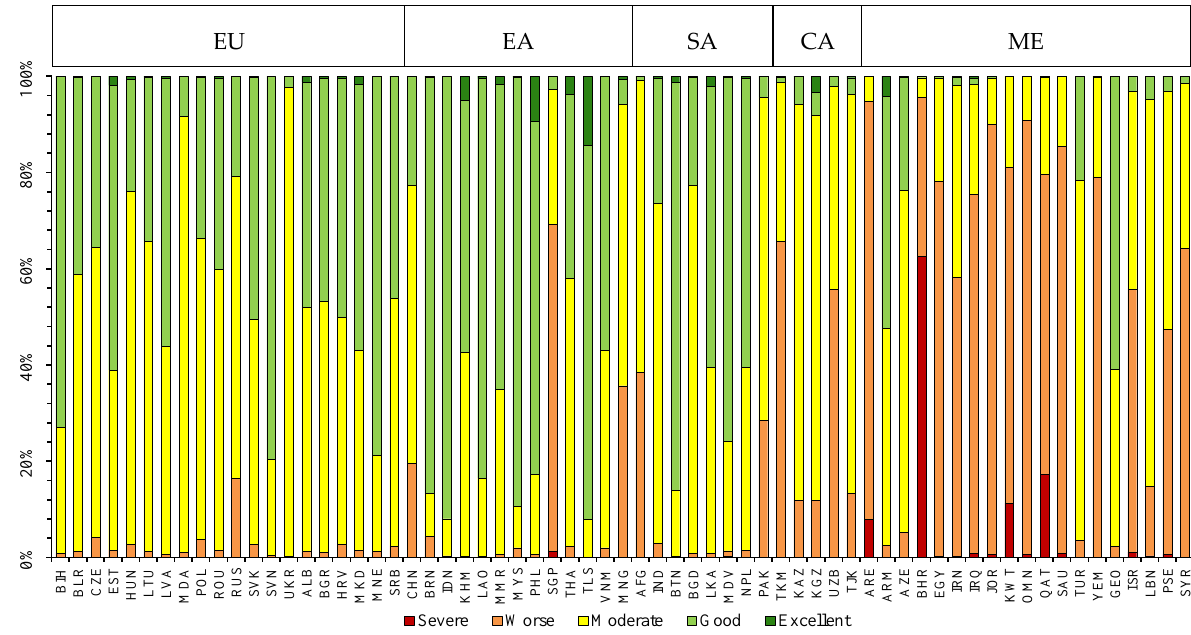
Figure 3. The proportion of ecological quality of 65 countries in the Pan-Third Pole region in 2020. The total area of ecological quality level change in the Pan-Third Pole region from 2000 to 2020 was 5.81 million km 2 , accounting for 11.76% of the total land area, of which the area of positive change was 3.46 million km 2 , accounting for 59.55% of the total change area. It was found that over the past 20 years, the area of “excellent” quality decreased by 0.03 million km 2 , the area of “good” quality increased by a net of 0.98 million km 2 , the area of “moderate” level decreased by 0.79 million km 2 , the net decrease of the area of “worse” level was 0.12 million km 2 , and the net decrease of the area of “severe” quality was 0.03 million km 2 (Table 6). In general, the changes of ecological quality in the Pan-Third Pole region were dominated by bidirectional changes between “worse” and “moderate” quality and between “moderate” and “good” quality over the past 20